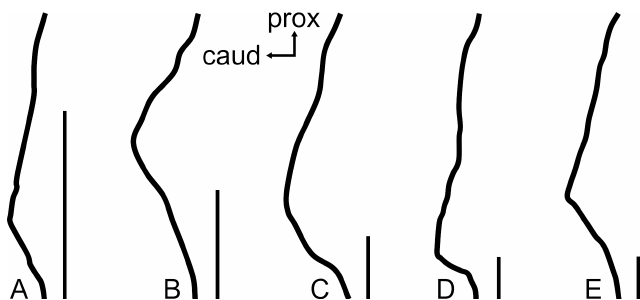
Figure 4. Comparative line drawings of the fourth trochant- er from Edmontosaurus annectens , showing variation in the proximo-distal position of the trochanter’s apex. The arrow diagram indicates proximal (prox) and caudal (caud) direc- tions. Specimens are arranged from smallest (left) to largest trochanter (right), for A) RAM 7967; B) LACM 23504; C)